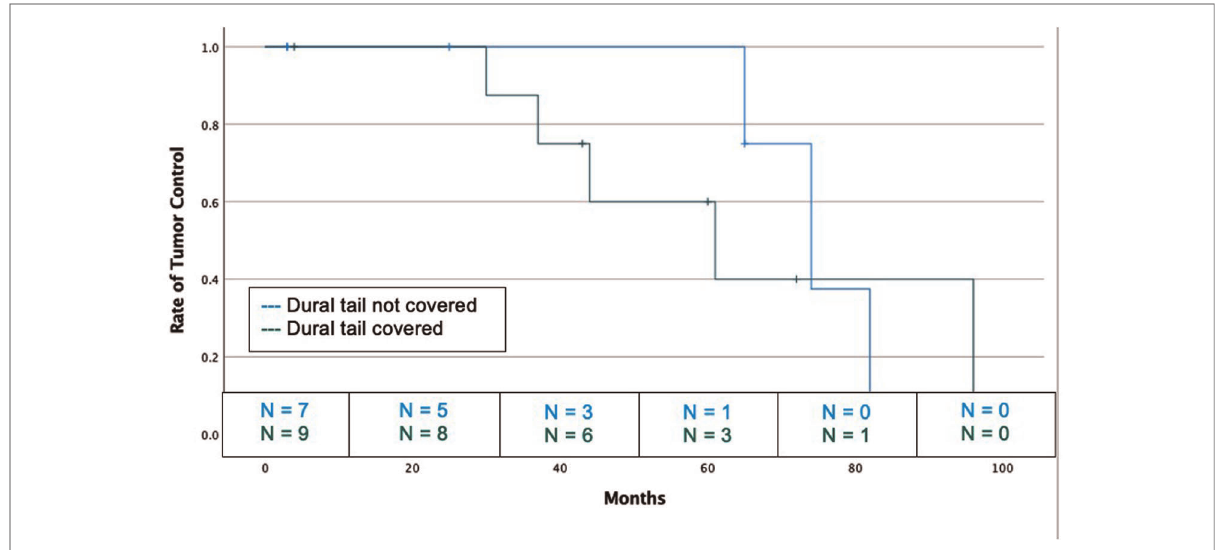
FIGURE 4 Kaplan-Meier graph demonstrating rate of tumor control or dural tail covered and not covered tumors for high grade (WHO grade 2 and 3) tumors. Blue: Dural tail not covered, Green: Dural tail covered. Dashes indicate censored patients due loss of follow-up or death. Number of patients remaining without recurrence or loss to follow-up is provided along the x-axis at 20-month intervals (Log Rank P